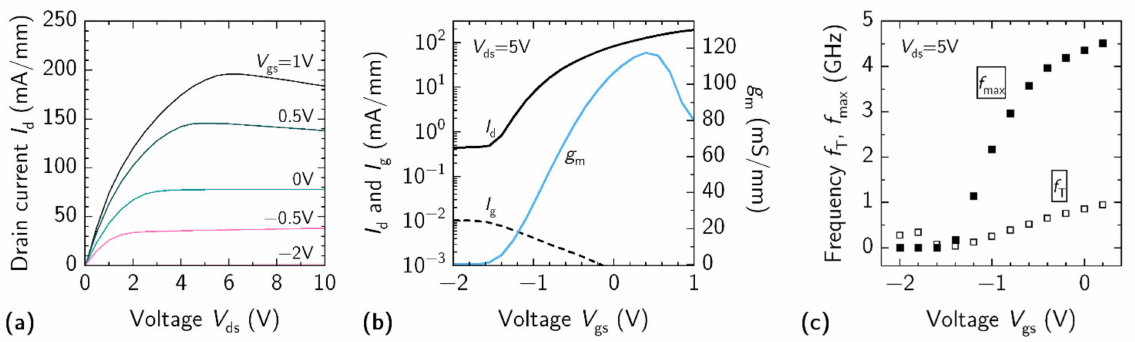
Figure 8. ( a ) Output characteristics, ( b ) transfer characteristics and ( c ) f T and f max frequencies measured for the same HEMT with L g = 5 µ m and L ds = 12 µ